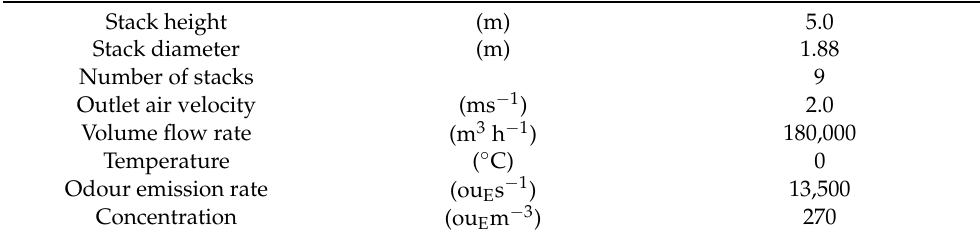
Table 4. Source term data for dispersion